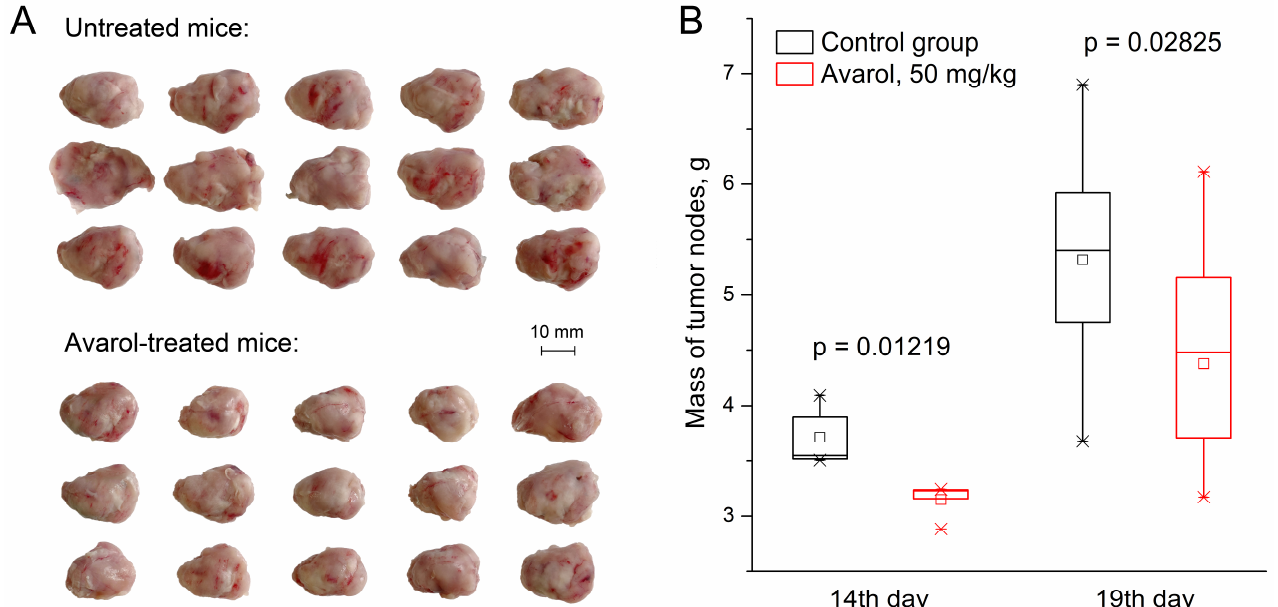
Figure 3. Influence of avarol on the dynamics of CC-5 growth. Graphic deviations correspond to SDs; *—statistically significant difference in tumor volume compared to control. Dotted lines—as- sessment of the duration of growth retardation (days) in the time of a five-fold increase in tumor volume. Arrows (and numbers next to them) indicate a graphical estimate of the time of a five-fold increase in the volume of the tumor node.